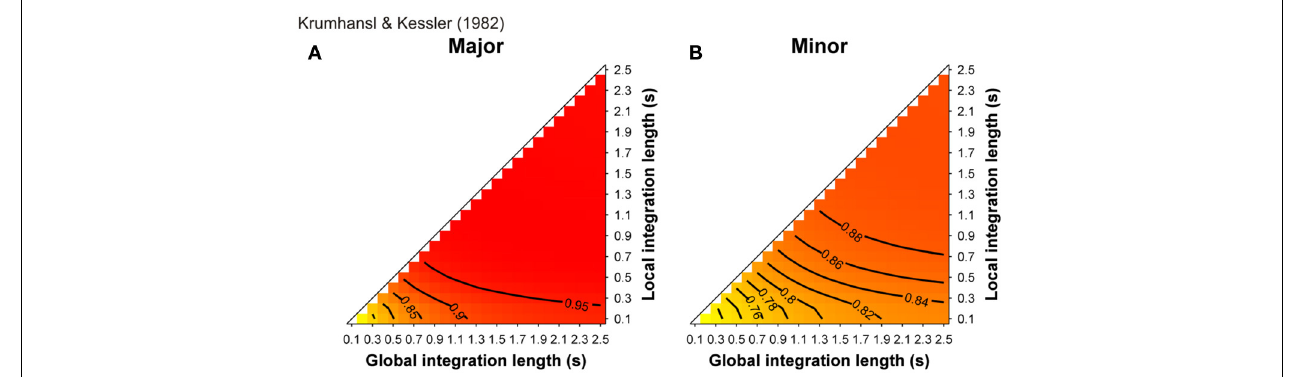
FIGURE 14 | (A,B) Correlation values between the simulated tone profiles and the profiles obtained by Krumhansl and Kessler (1982) with the scale contexts of major and minor modes, respectively. r coefficients are reported as